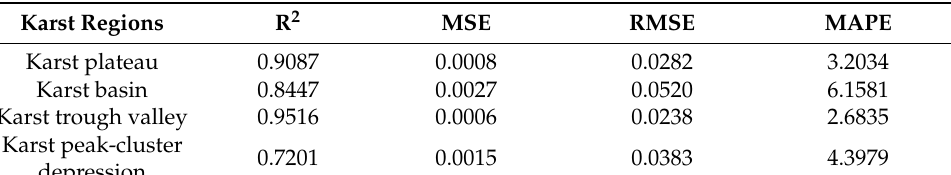
Table 2. The prediction accuracy of the RBFNN model.